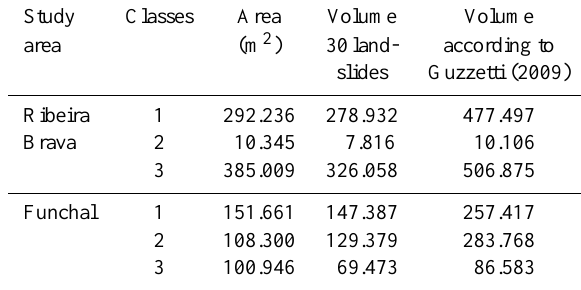
Table 3. Minimum and maximum landslide volumes for the two affected areas: Class 1: new scars; Class 2: old scars (prior to